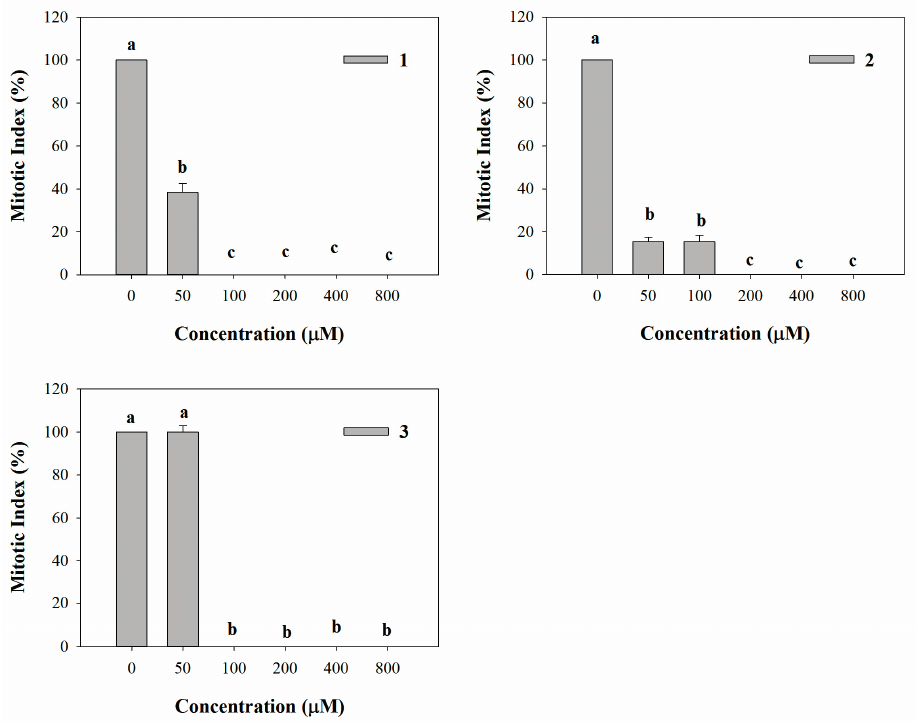
Figure 6. Mitotic sites number evaluated along the primary root of A. thaliana seedlings treated with the synthetic coumarins 1 – 3 . Data are expressed as percentage of the control. Different letters (a–c) along the curves indicate significant differences at p ≤